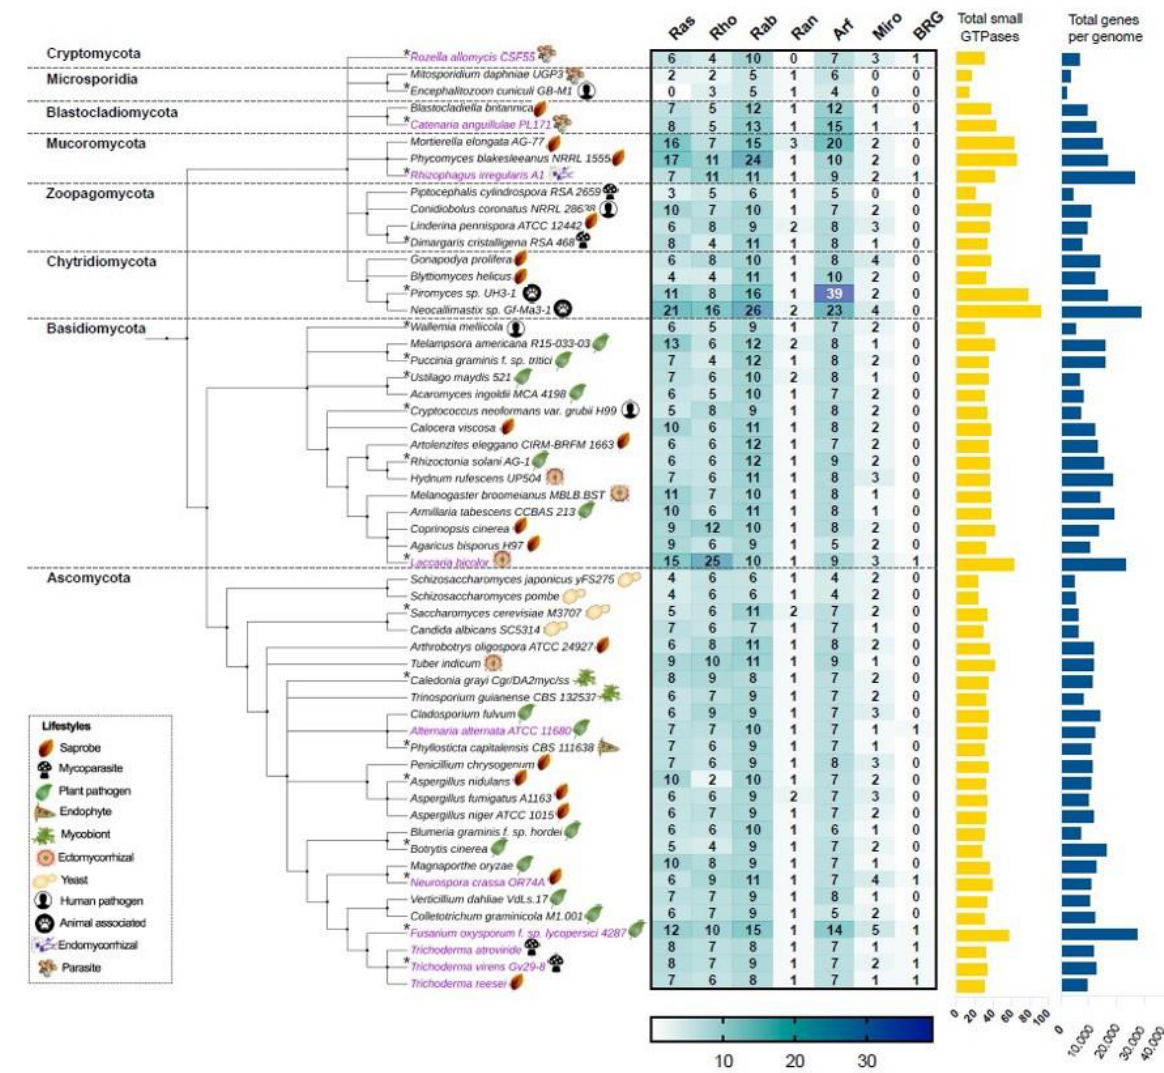
Figure 2. The Ras, Rho, Rab, Ran, Arf, Miro, and BRG families of the small Ras GTPases superfamily are present in the fungal kingdom. The taxonomic tree was generated using phyloT based on the NCBI taxonomy. Each phylum is indicated in its corresponding cluster. The numbers of members of each family are indicated in the heat-map table, which were obtained by searching in MycoCosm of JGI using PF00071, PF00025, and PF08477 keys as search criteria. The total number of small GTPases for each species are indicated in the yellow bars. The total number of genes of each genome were also obtained in MycoCosm and are indicated in blue bars. A representative lifestyle for each strain is indicated with icons. Those strains that contain putative BRGs in their genomes are indicated in magenta. The asterisks indicate the 20 species that were selected for further analysis.